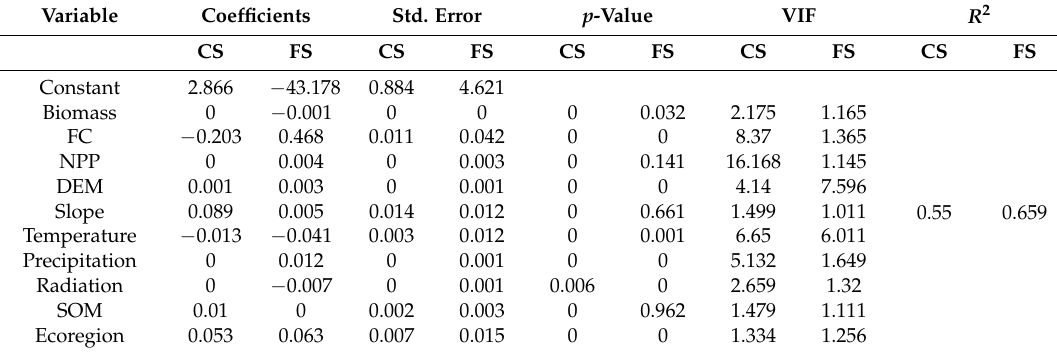
Table 3. Results of Least Squares Regression collinearity